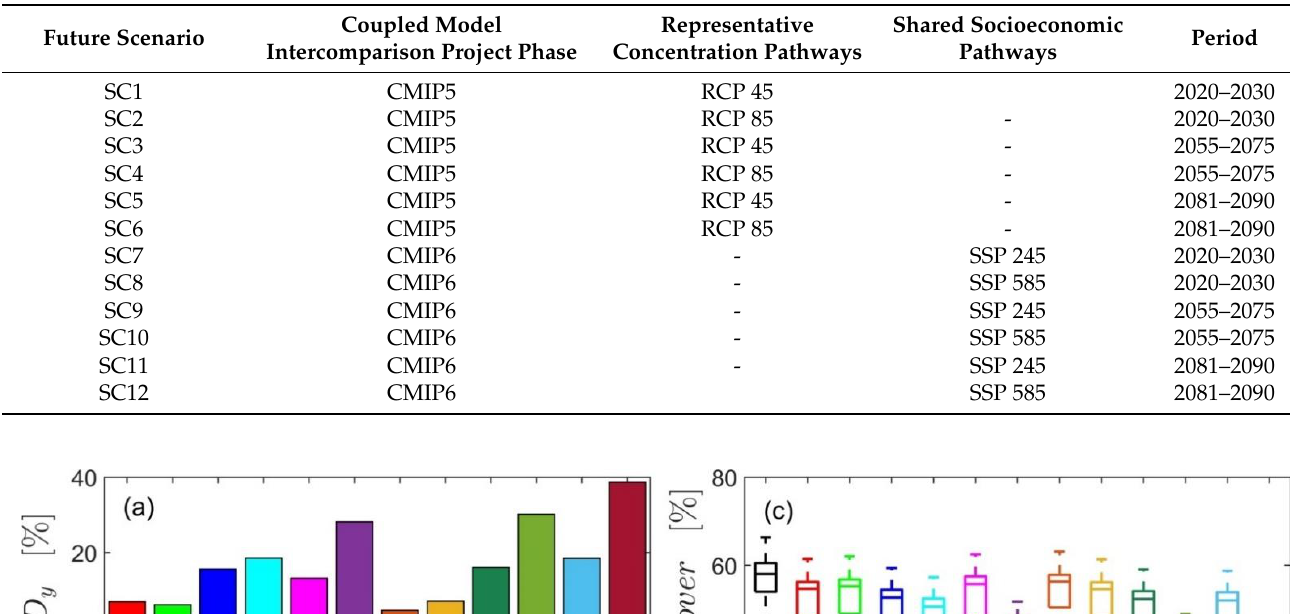
Table 5. The twelve future scenarios of the CMIP5 and CMIP6 [79,81].